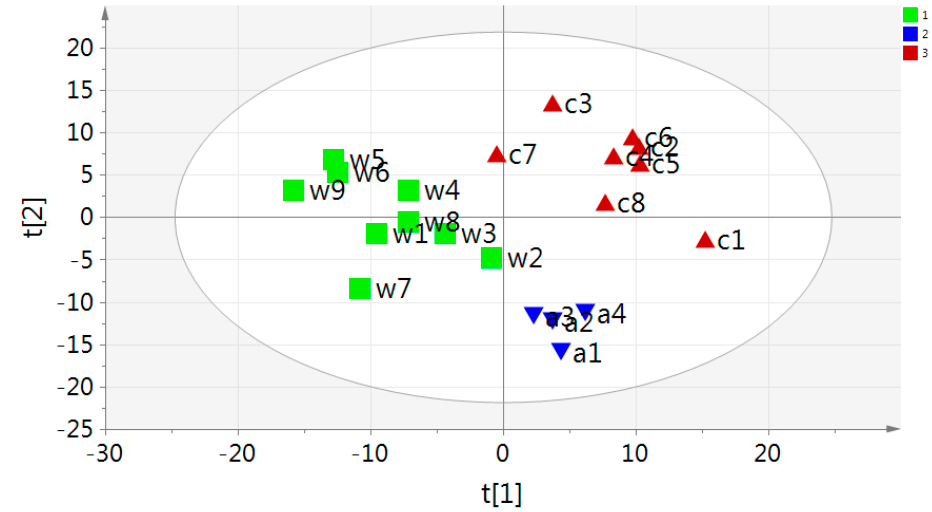
Figure 6. Principal component analysis (PCA) score plot of agarwood (group 1: wild agarwood; group 2 and 3: cultivated agarwood). Int. J. Mol. Sci. 2016 , 17 , 771 Table 3. Identified metabolites differing between wild and cultivated agarwood by UPLC-QTOF-MS.